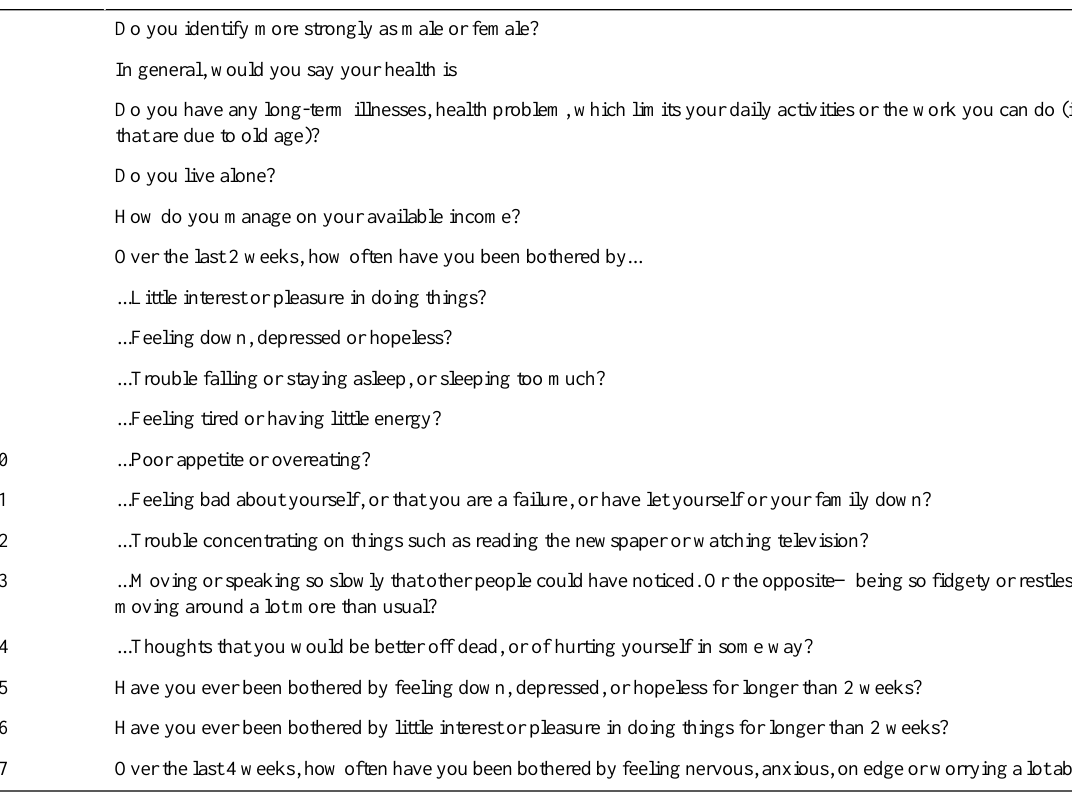
Table 2. Items forming the diamond clinical prediction tool. TextItem